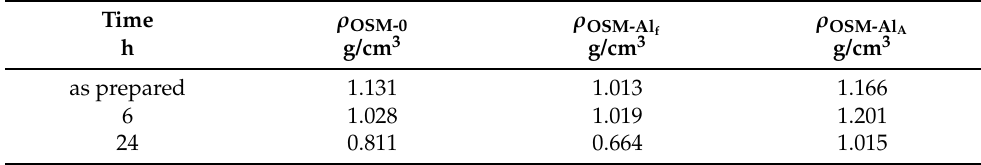
Figure A3. Raman spectra of OSM-Al A in the beginning (10 min—black line) and after 360 min from preparing the material. Table A1. Density of OSM samples at selected times after their